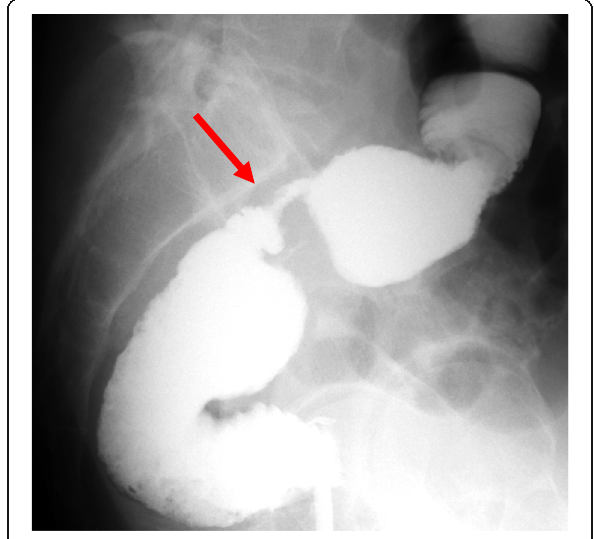
Fig. 4 Gastrografin enema showed narrowing at the ileal pouch inlet (red arrow)